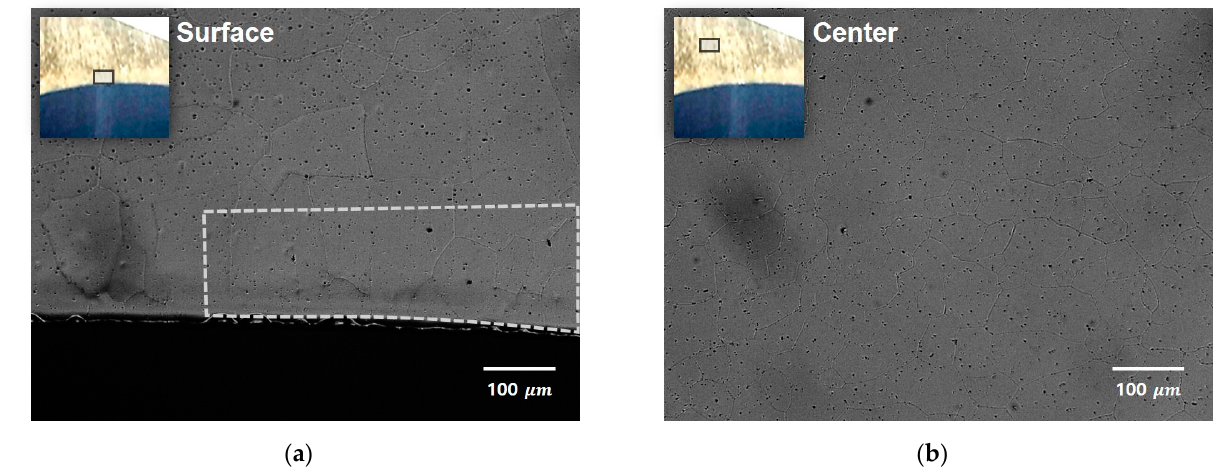
Figure 17. Microstructures of the defective region: ( a ) surface; and ( b ) center.